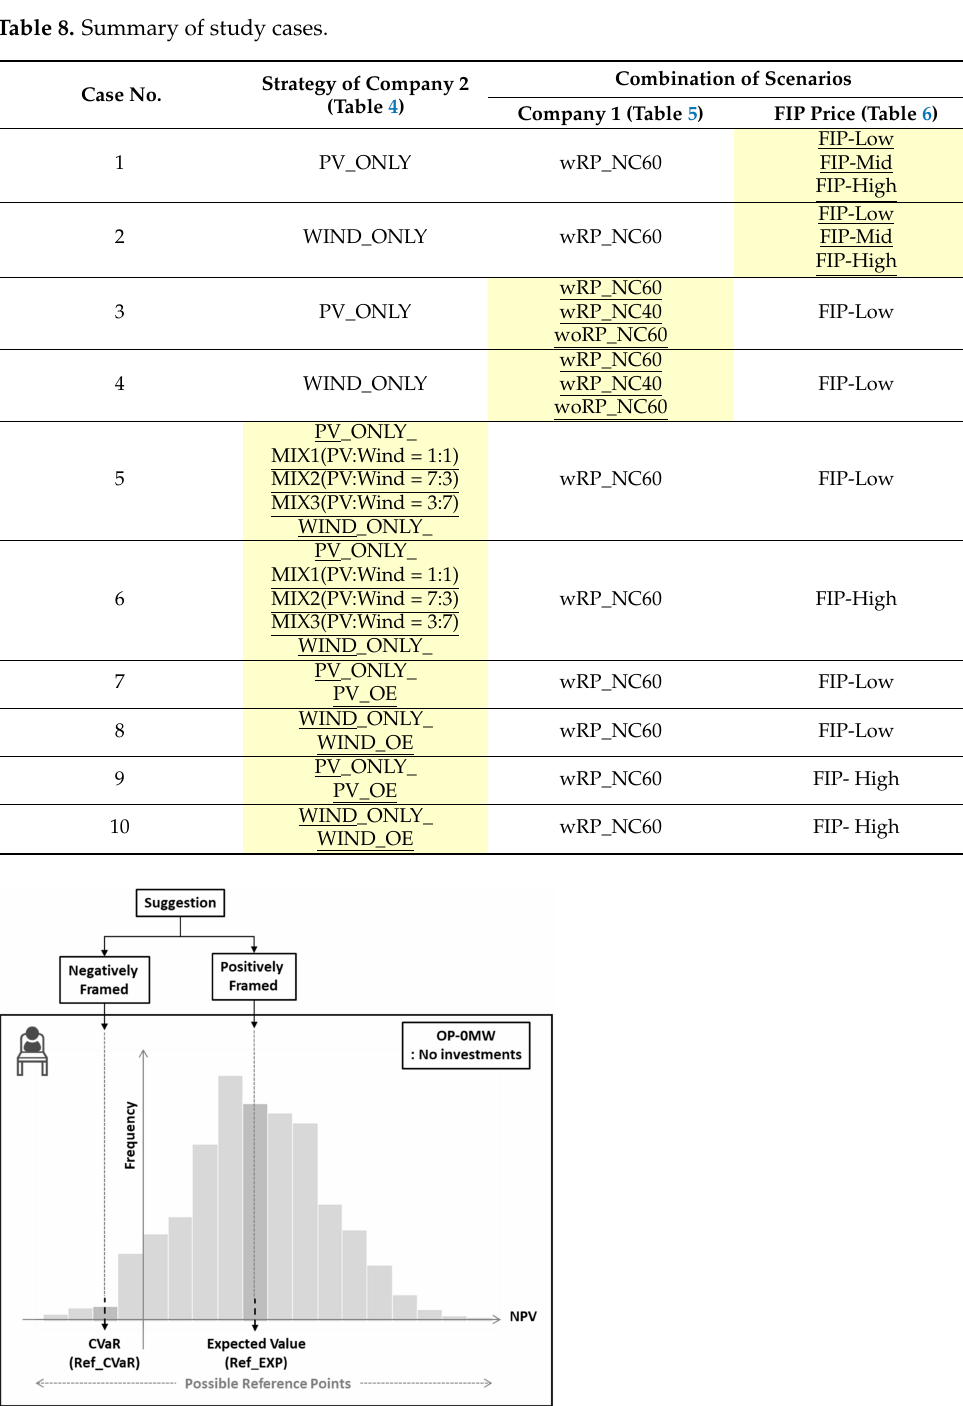
Figure 7. Concept of selected reference points for the decision making of the top